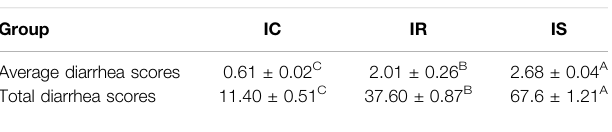
TABLE 1 | Analyses of the diarrhea scores of piglets among the IR, IS, and IC groups. Group IC IR IS Average diarrhea scores